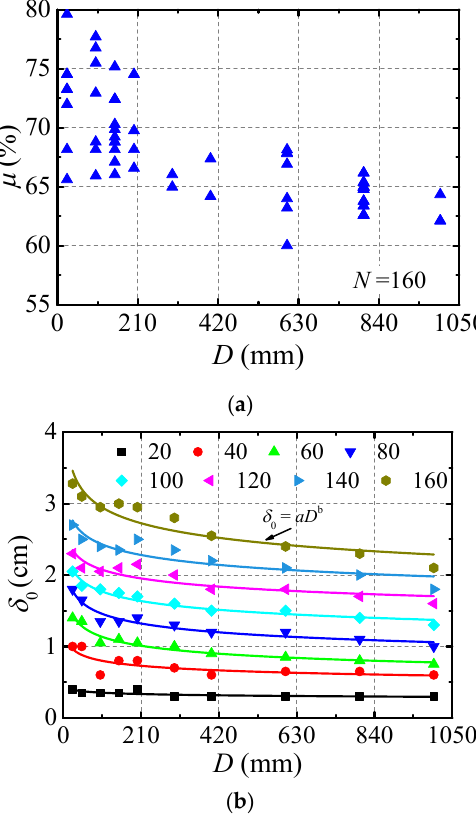
Figure 6. Radial ice size: ( a ) icing range and ( b ) ice thickness at θ = 0°.